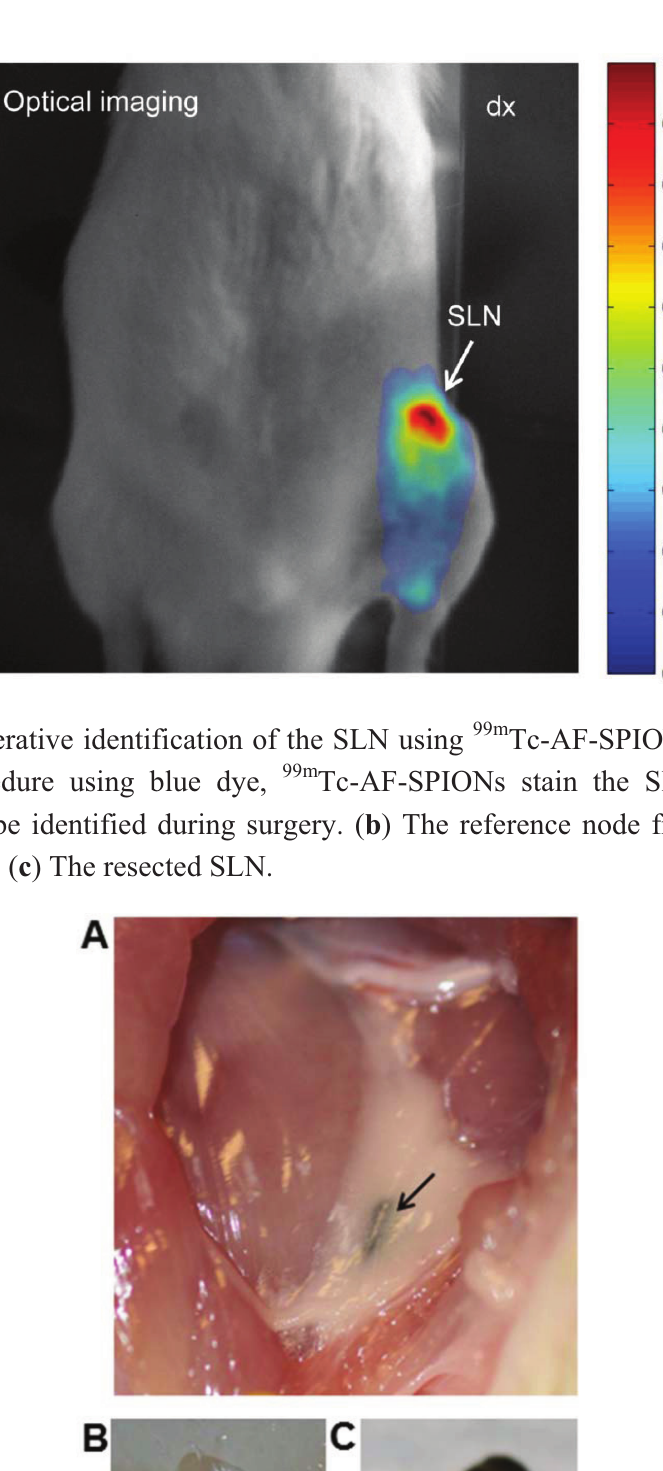
Figure 4. Optical fluorescence image visualizing the SLN. High signal to background ratio is demonstrated which encourage for possible translation of this approach to clinical applications.